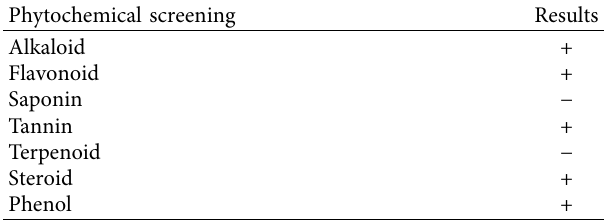
Table 1: Phytochemical screening of extract E. alba rhizome. Phytochemical screening Results